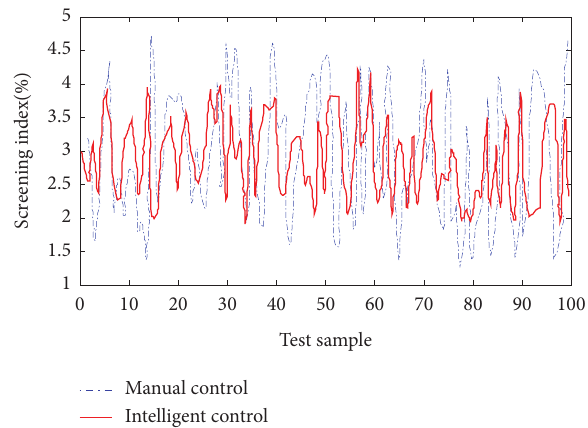
Figure 11: Comparison of mineral rational energy screening index of finished pellets.